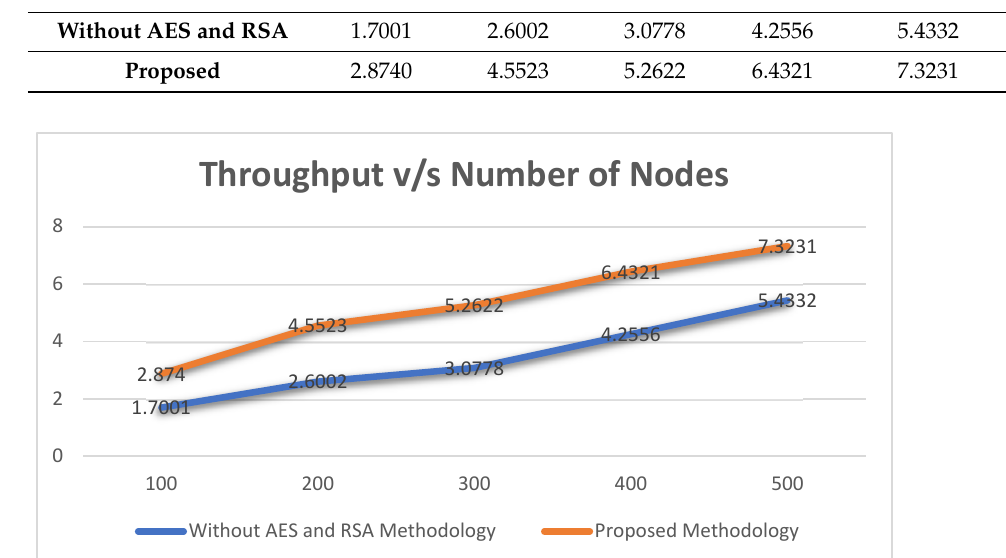
Figure 8. Throughput vs. number of nodes.